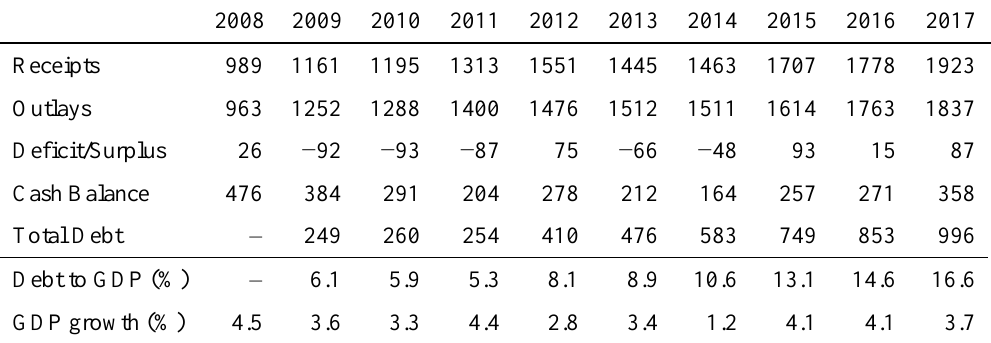
Table 1. Receipts, Outlays, Deficit/Surplus, Cash Balances and Public